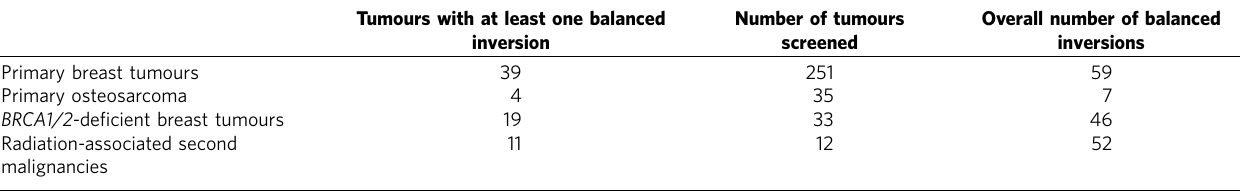
Table 1 | Survey of balanced inversions in different tumour types.